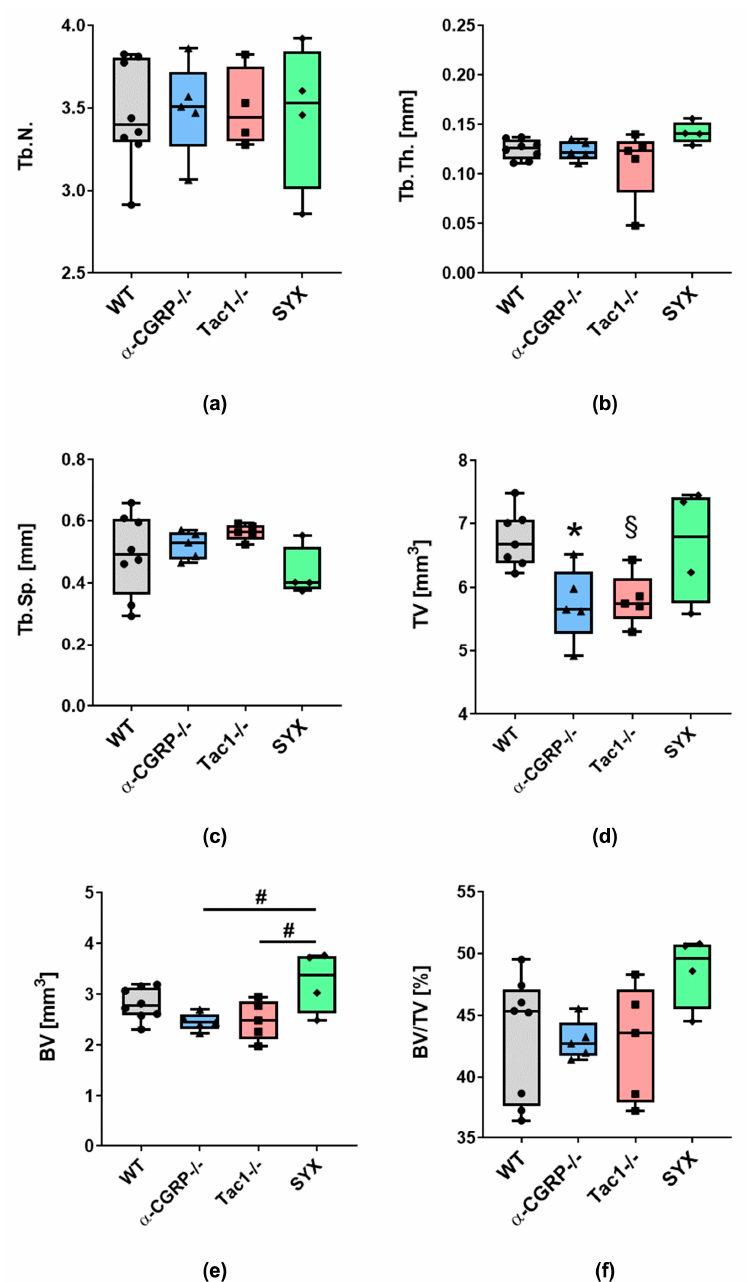
Figure 2. µCT analysis of fractured femora at 21 days after fracture of WT, α -CGRP − / − , Tac1 − / − , and SYX mice. ( a – c ) Trabecular bone properties. Trabecular number ( a ), thickness ( b ) and separation ( c ) within the callus region of fractured femora. ( d ) Total volume (TV) of the callus region of fractured femora. ( e ) Bone volume (BV) of the newly formed trabecular bone structure and the cortical bone within the callus region of fractured femora. ( f ) Bone volume/total volume (BV/TV) within the callus region of fractured femora. * indicates differences between neurotransmitter-deficient groups and WT animals. # over lines indicate differences between neurotransmitter-deficient groups. */# = p ≤ 0.05. § indicates a trend compared to WT, § = p = 0.0532. (nWT = 8, nCGRP − / − = 5, nTac1 − / − = 5, nSYX = 4).